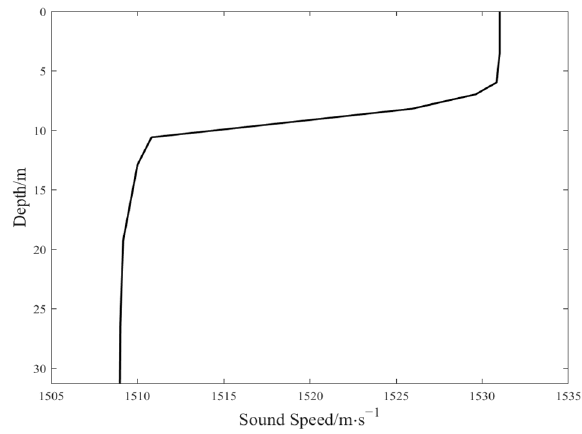
Figure 1. Sound speed profile measured in experiment .